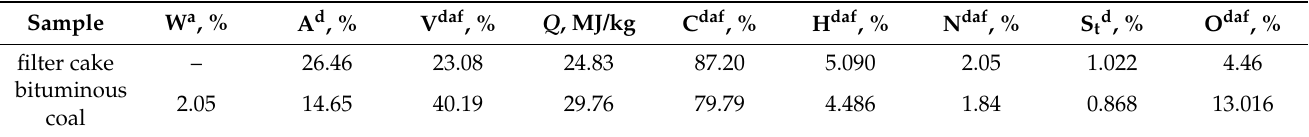
Table 2. Ultimate and proximate analysis of filter cake and coals.